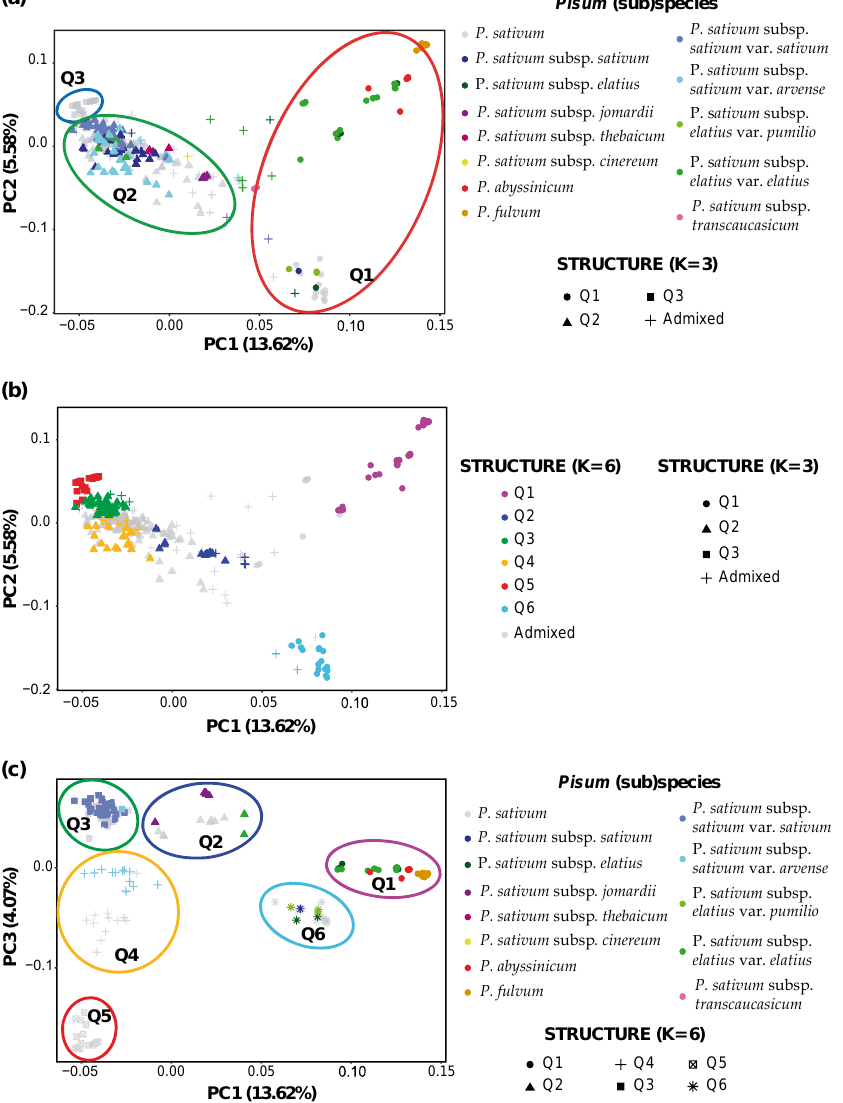
Figure 5. Population structure of the IAS pea core collection as estimated by PCA. The figure shows the PCA analysis of the 11,635 polymorphic SilicoDArT markers for the 325 accessions of the IAS pea core collection. ( a ) Scatterplot of the first two PCs. Each accession is represented by a coloured symbol depending on its STRUCTURE subpopulation for K = 3 and its pea subspecies. ( b ) Scatterplot of the first two PCs with information of the STRUCTURE output for K = 6. ( c ) Scatterplot of PC1 vs . PC3 that allow a better separation of the six STRUCTURE subpopulation. Each accession is represented by a coloured symbol depending on its STRUCTURE subpopulation and subspecies. Superposing the STRUCTURE clustering for K = 3 or K = 6 to the PCA clustering favours the estimation of six subpopulations (Figure 5b). In this case, the two smaller PCA groups corresponded to the STRUCTURE subpopulation Q1 and Q6 respectively. The other STRUCTURE subpopulations were included within the leading PCA group in four distinct clusters (Figure 5b). The presence of six subpopulations was further supported